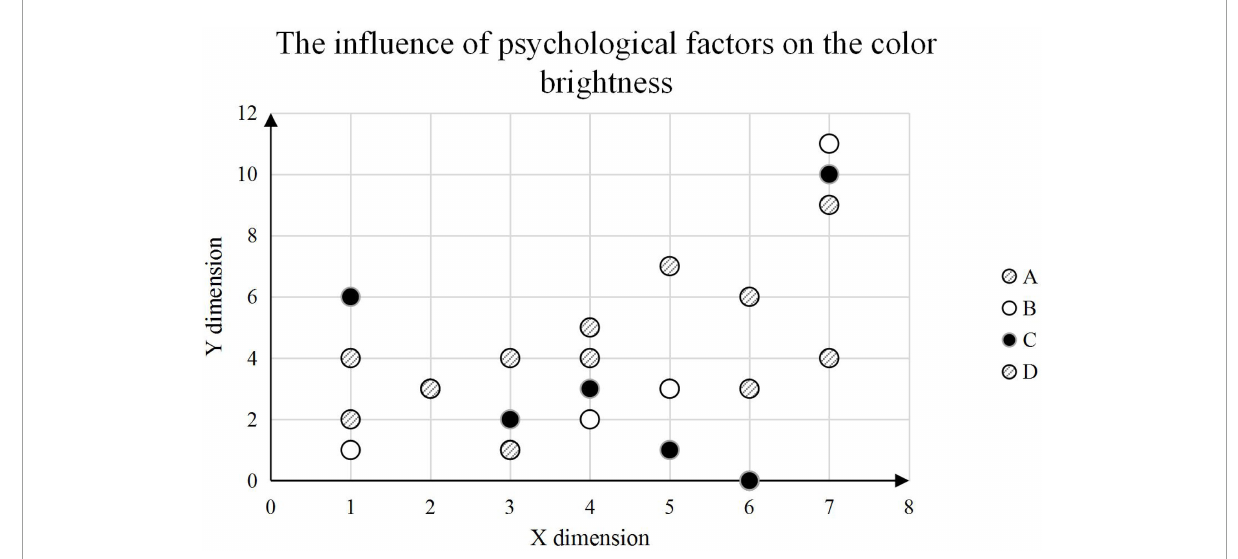
FIGURE9 The influence of psychological factors on the judgment of color brightness.